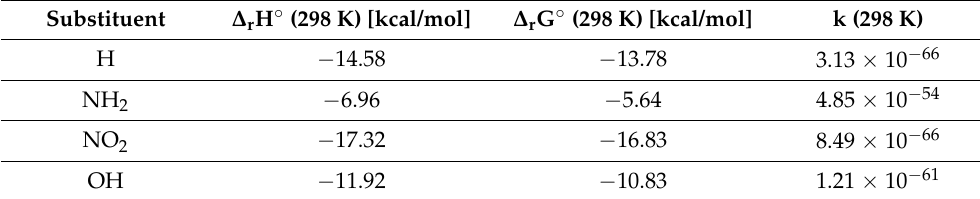
Table 8. Thermodynamic parameters for the keto-enol reaction of 1,8-dihydroxy-9-anthrone. Substituent